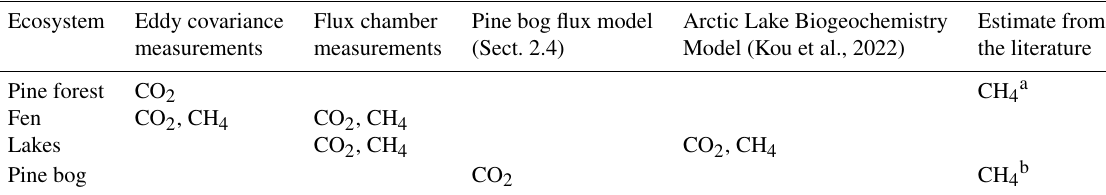
Table A7. Data sources for different ecosystems.